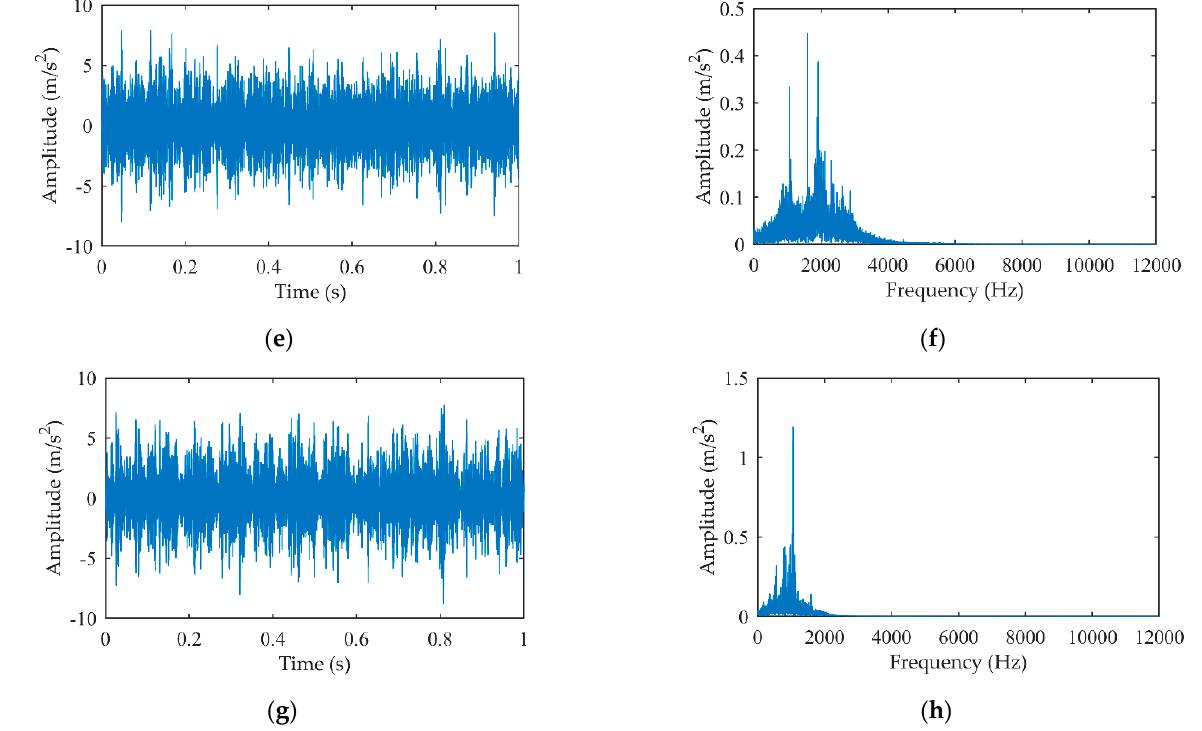
Figure 9. The first four IMFs of the single ‐ stage gearbox experiment signal: ( a ) IMF1; ( b ) Amplitude spectrum of IMF1; ( c ) IMF2; ( d ) Amplitude spectrum of IMF2; ( e ) IMF3; ( f ) Amplitude spectrum of IMF3; ( g ) IMF4; ( h ) Amplitude spectrum of IMF4.